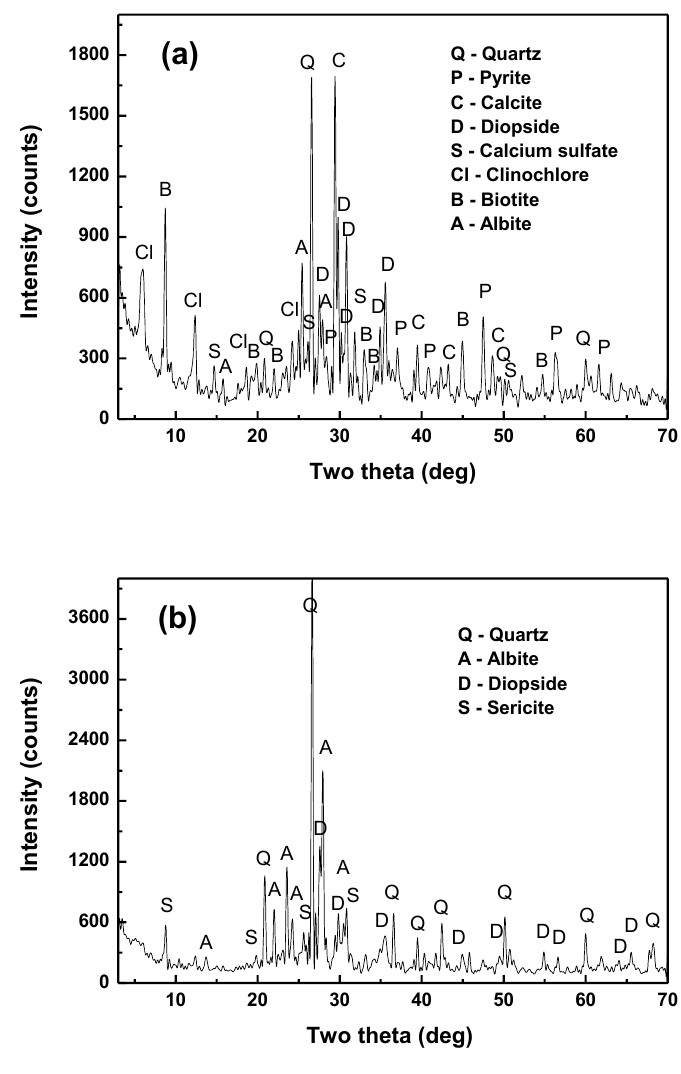
Figure 1. XRD (X-ray diffraction) patterns of ( a ) iron ore tailings and ( b ) barren rocks. Table 1. Chemical composition of iron ore tailings and barren rocks.